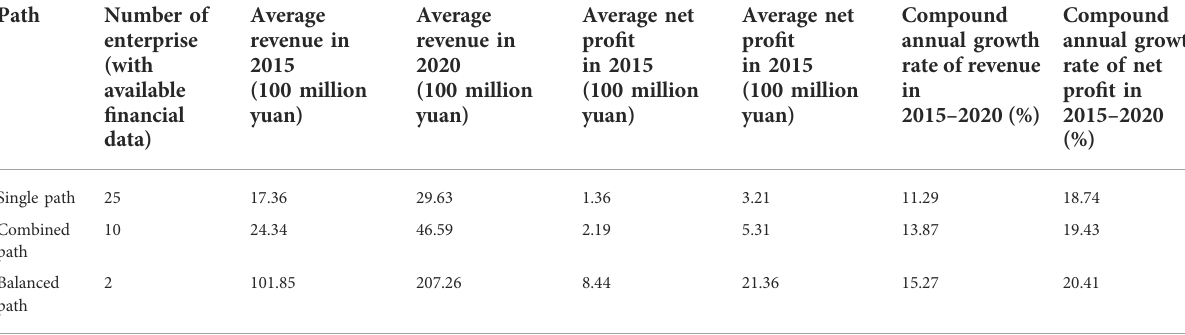
TABLE 5 Growth of PCB enterprises with different transformation and upgrading